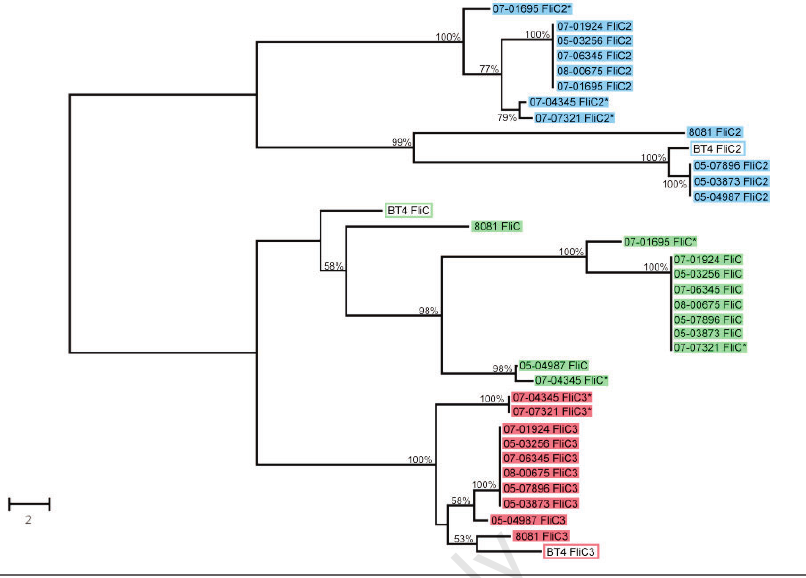
Figure 4. Phylogenetic analysis of flagellin proteins FliC (green), FliC2 (blue) and FliC3 aligned in Fig. 3 from 10 Y. enterocolitica biotype 1A strains, from Y. enterocolitica bio- type 1B strain 8081 (“8081”), and from Y. enterocolitica biotype 4 (“BT4”, enframed); midpoint rooted neighbour joining method. Asterisks indicate relocated flagellin genes compared to the order of flagellin genes found in Y. enterocolitica 8081 (Figure 1C). Bootstrap values above 50% are